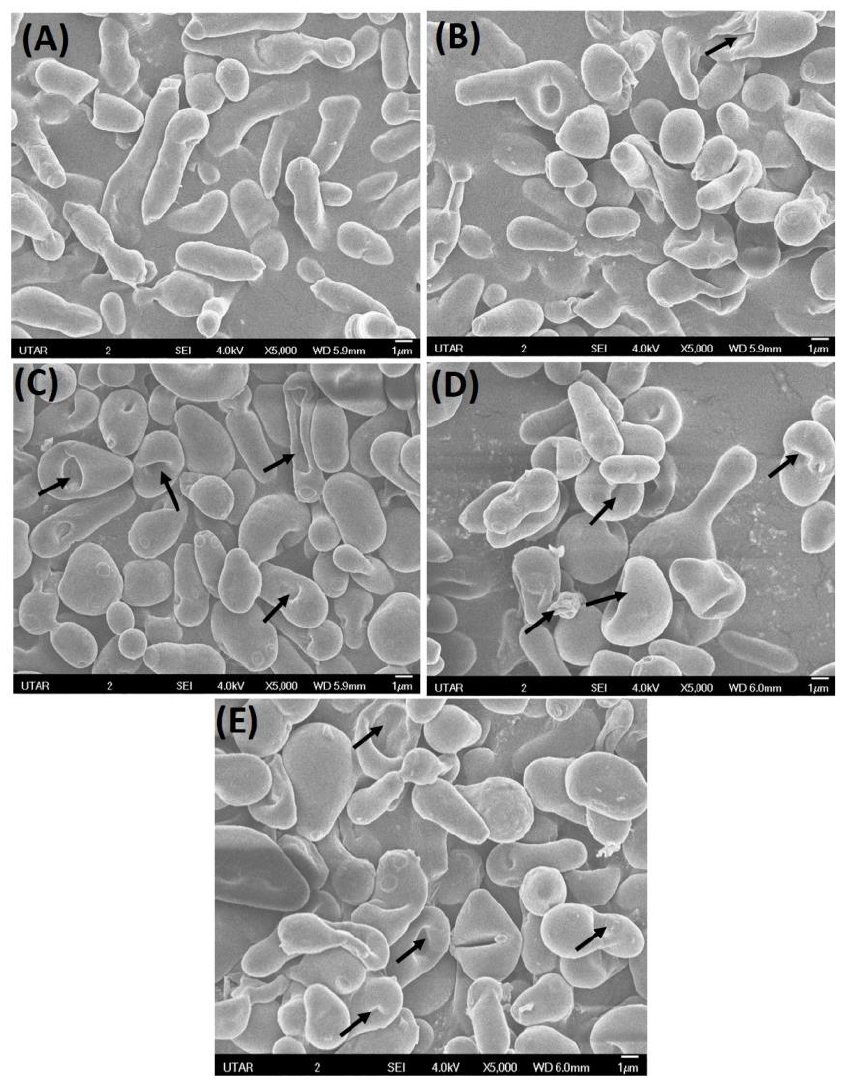
Figure 6. SEM images of S. cerevisiae without ZnO NPs treatment (negative control) ( A ), treated with 100 μg/ mL of ZnO NPs showing rupture of cell membrane ( B ) and regional invagination and pitting of yeast cell surface ( C ), treated with 150 μg/ mL of ZnO NPs showing cell wrinkle ( D ), and cracks and deformity on the cells ( E ) at 24 h.